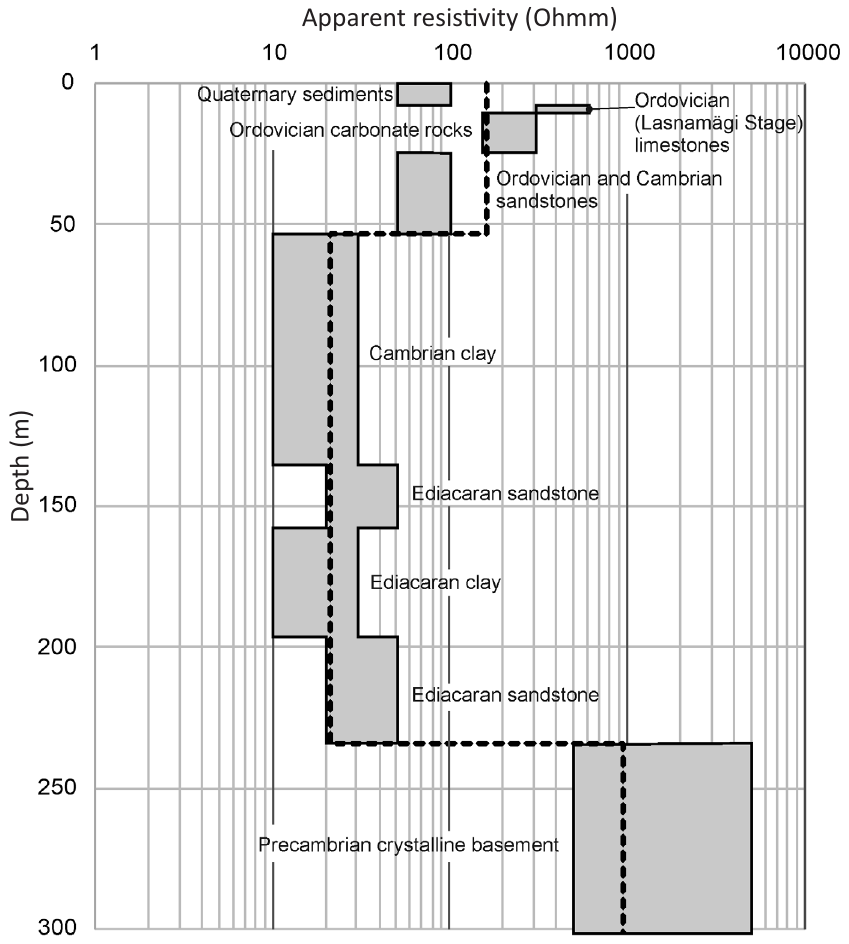
Fig. 5. Apparent electrical resistivity section at the Jõhvi western anomaly as based on the FrEM experiment. The grey areas mirror the geological section at the western anomaly (Erisalu et al. 1969) and apparent resistivities derived from Jõeleht & Kukkonen